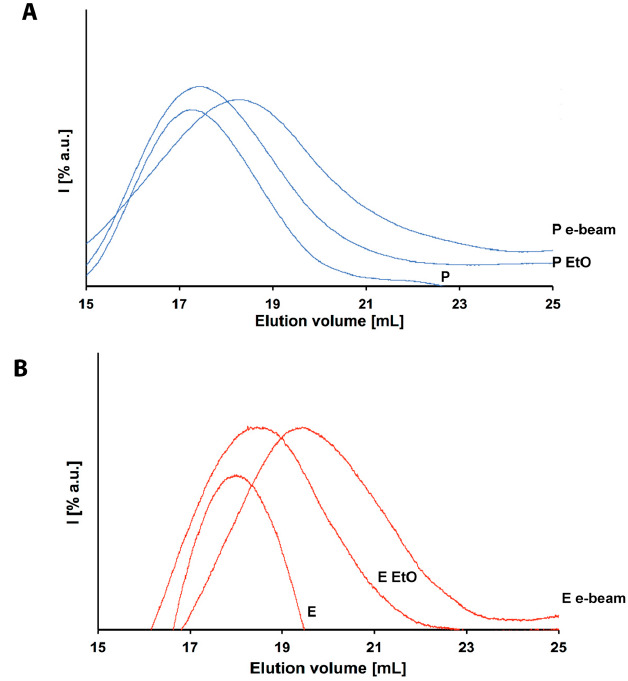
Figure 4. GPC chromatograms of: ( A ) P, P EtO and P e-beam (blue lines); ( B ) E, E EtO and E e-beam (red lines).